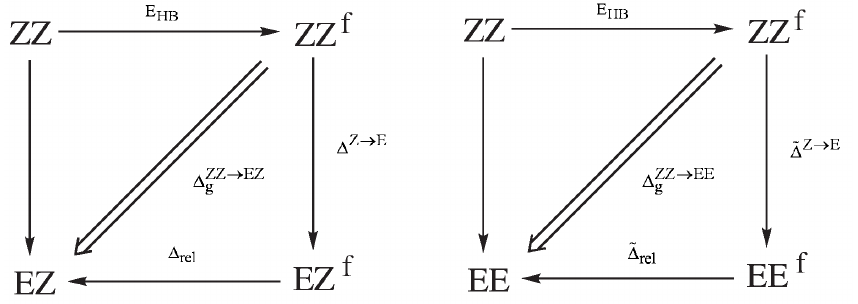
Figure 10. Energy dependencies between the respective forms of 3-aminoacrolein used in deriving the formula for the energy of the intramolecular N-H · · · O hydrogen bond in the ZZ form, according to Geometry-Corrected Method